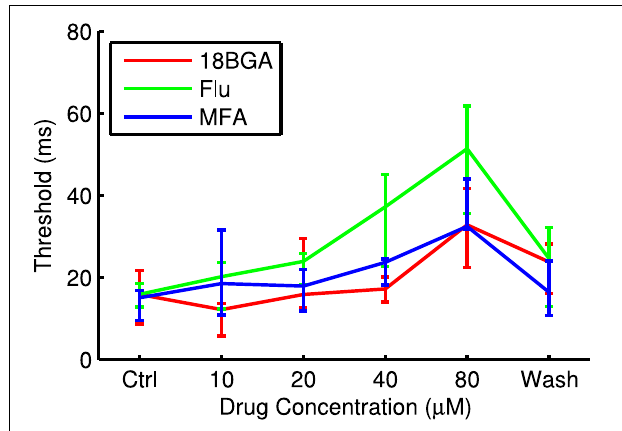
FIGURE 4 | Threshold flash duration for optogenetically sensitive cells at each drug concentration. Data points are median over all retinas of the median threshold of all cells that respond in both control conditions and at 80 µ M drug. Error bars are IQR for all retinas.